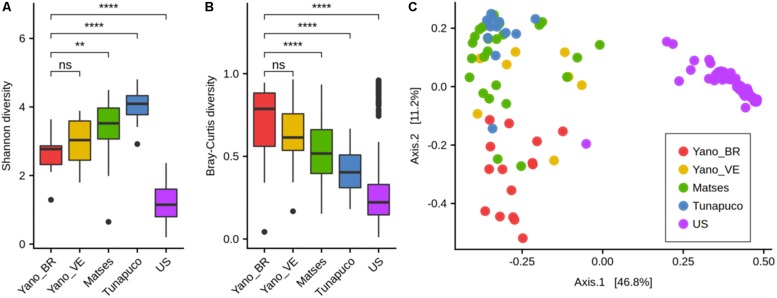
Alpha- and beta-diversity comparisons of the gut microbiomes of each group. Analyses were performed on genus-level taxa tables. ns, not significant; ∗∗P < 0.01, ****P < 0.0001 (Wilcoxon test). (A) Boxplot of the Shannon diversity of each group. (B) Bray–Curtis distances within each group. (C) Principal coordinate analysis of Bray–Curtis distances. The colors of the boxplots and dots represent the different groups analyzed according to the legend. Yano_BR, Yanomami/Brazil; Yano_VE, Yanomami/Venezuela; US, US individuals.